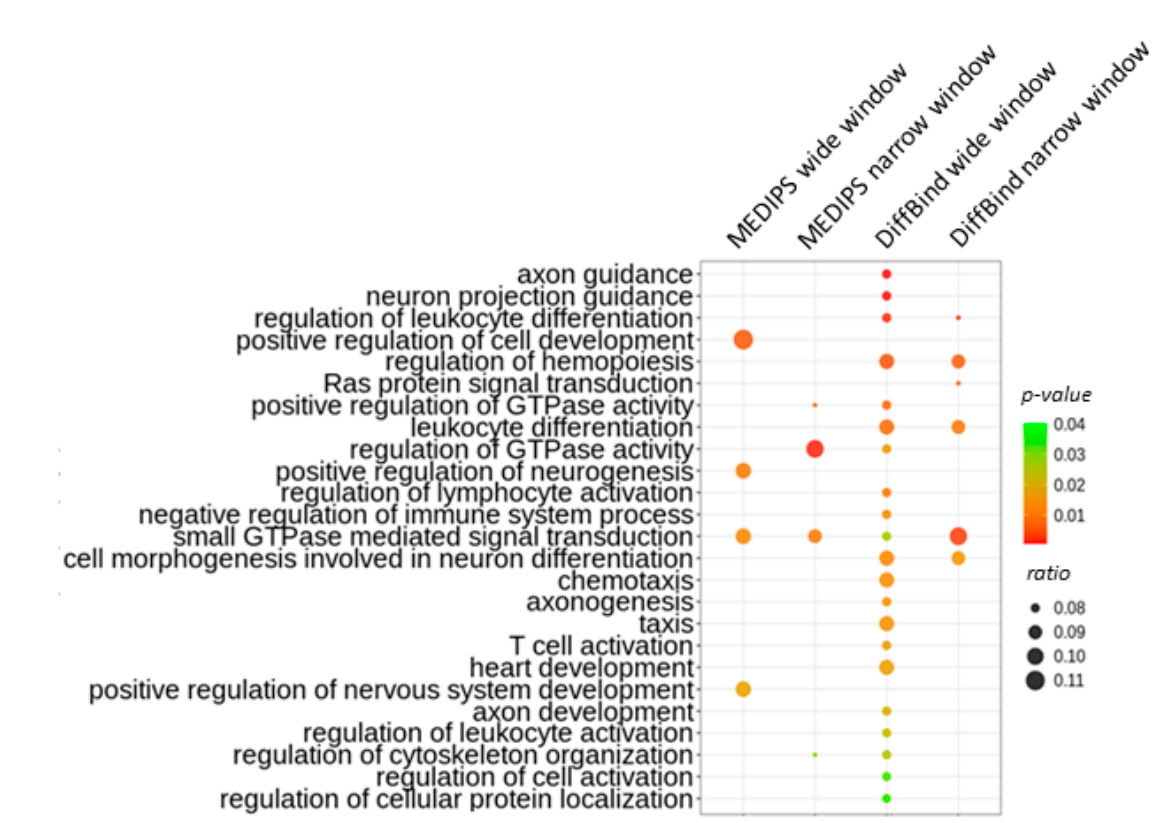
Figure 9. Biological processes most significantly associated with genes linked with age-associated differentially hydroxymethylated regions (DHMRs). The overrepresentation test of the Gene Ontology pathways was performed with the ClusterProfiler Package. Results are presented for p -values without the FDR correction.